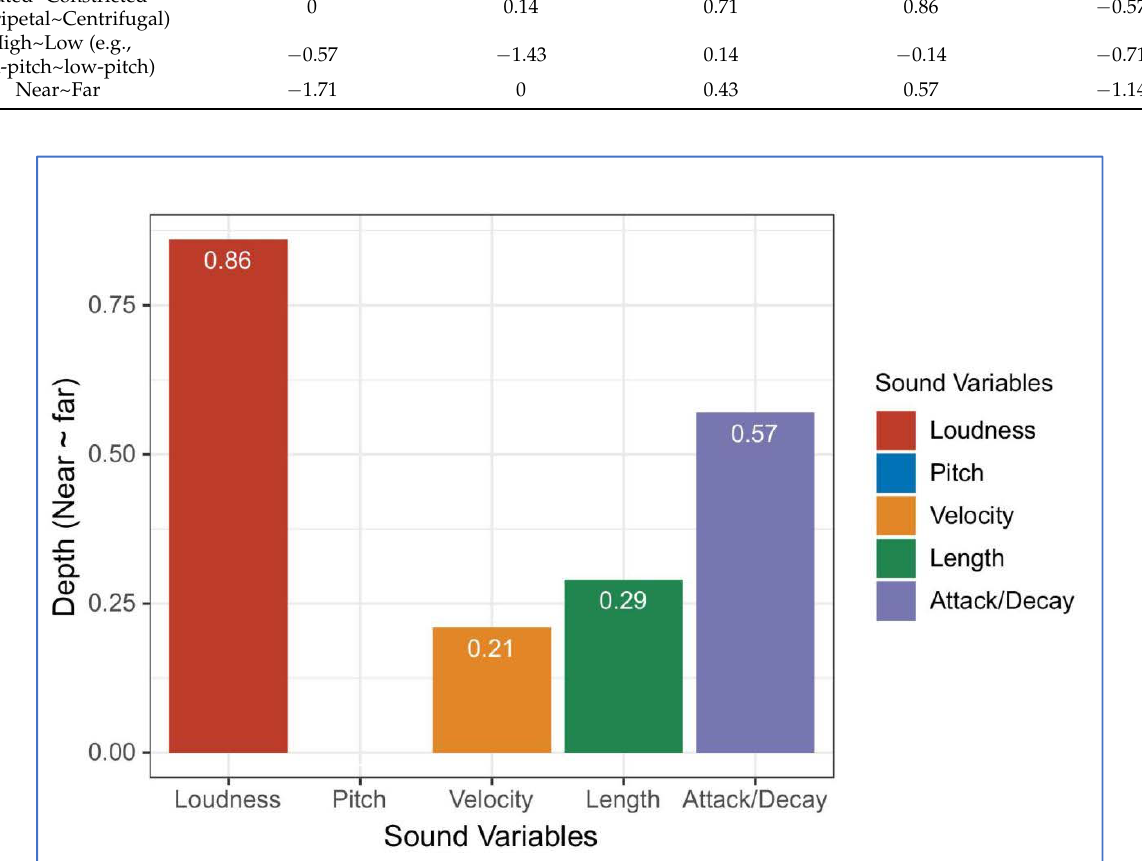
Figure 4. Matching results of sound variables with depth (Near~Far).